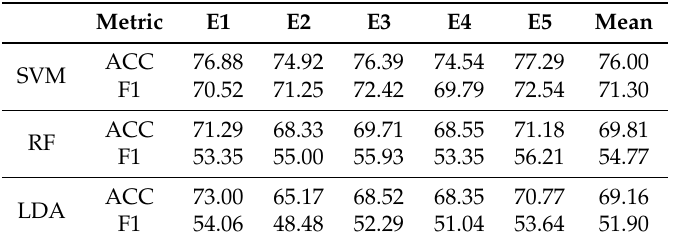
Table 3. Accuracy and F1 score between the WM fragments determined by the classifier and individual experts, 15 s, overlapping of 10 s, and N = 3.